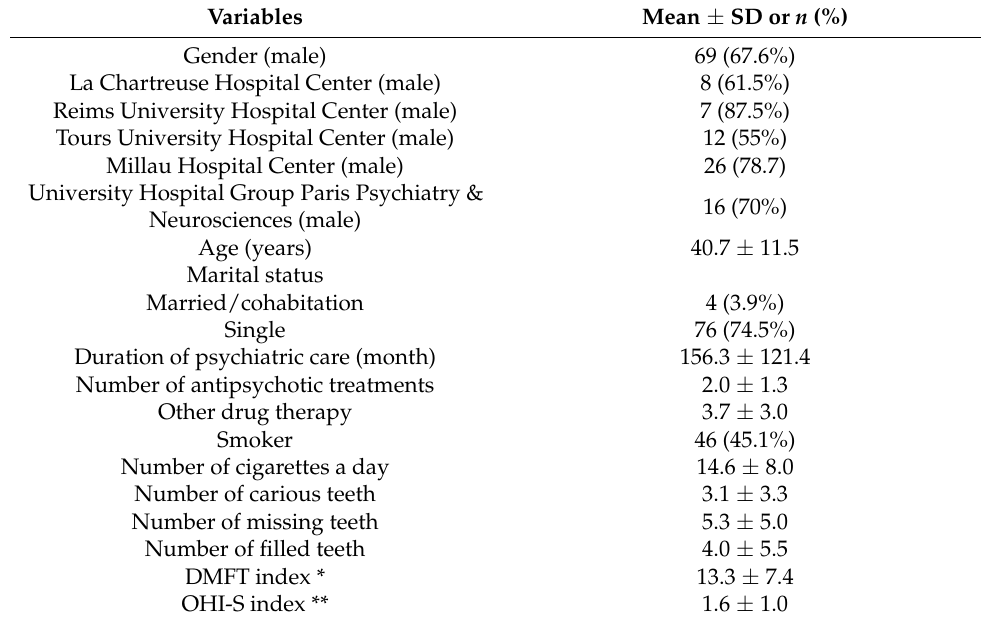
Table 1. Participants’ characteristics ( n =